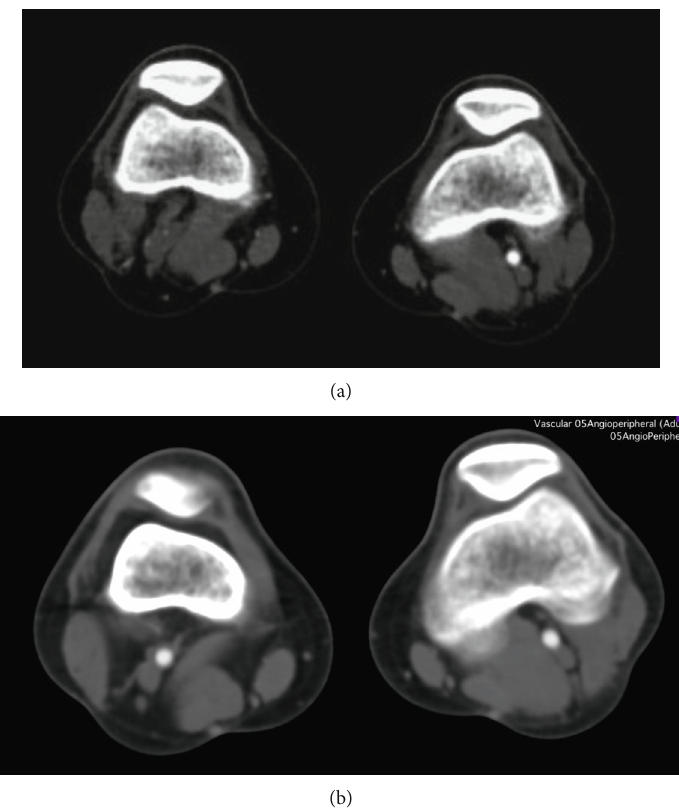
Figure 1: Transverse cut of the CT angiography at the level of the knee: (a) at time of presentation with the arrow showing an obstruction in the right popliteal artery and (b) done at 6 months postpresentation.